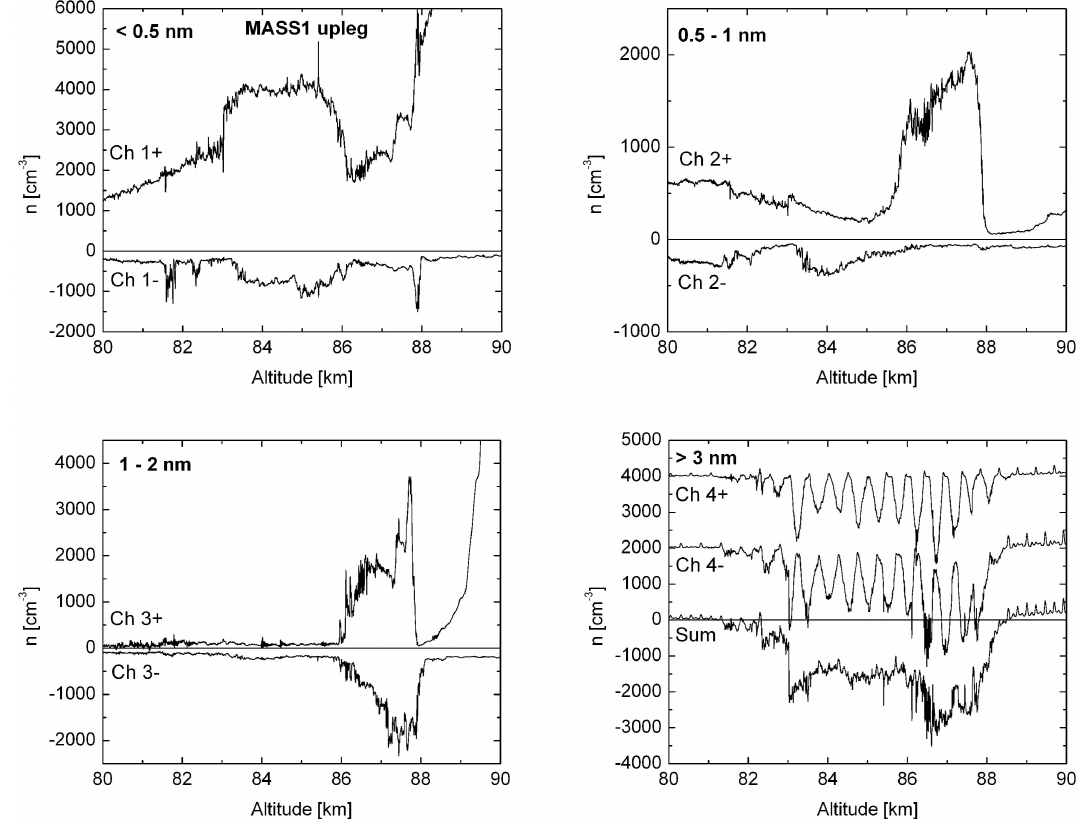
Fig. 6. Data from the 8 channels of the MASS instrument for the upleg of the first flight. Channels 4+ and 4 − are offset from zero for clarity and their sum is plotted